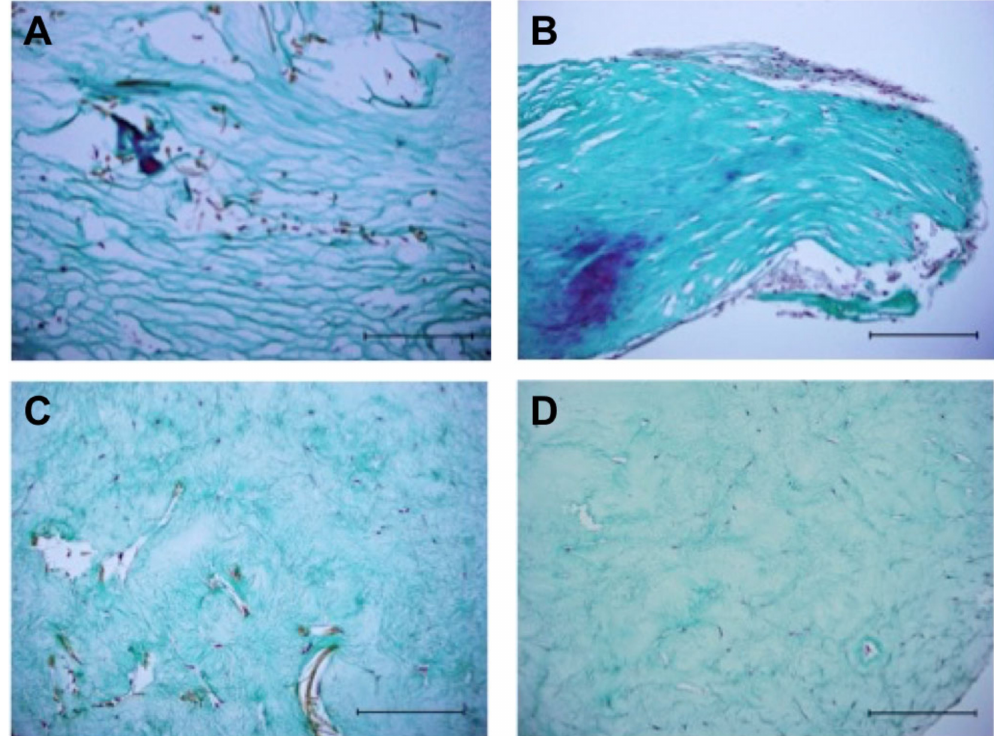
Figure 6. Masson–Goldner Trichrome stainings of all experimental groups. Collagenous connective tissue is stained green, the nuclei brown-black and the cytoplasm red. Elastic fibers often do not show a specific color and can be greenish or light red in color. The measuring bars represent 200 micrometers. ( A ). Construct containing spider silk and bioreactor cultivation (experimental group A). ( B ). Construct without spider silk and with bioreactor cultivation (experimental group B). ( C ). Construct with spider silk and without mechanical stimulation (experimental group C). ( D ). Construct without spider silk and without mechanical stimulation (experimental group